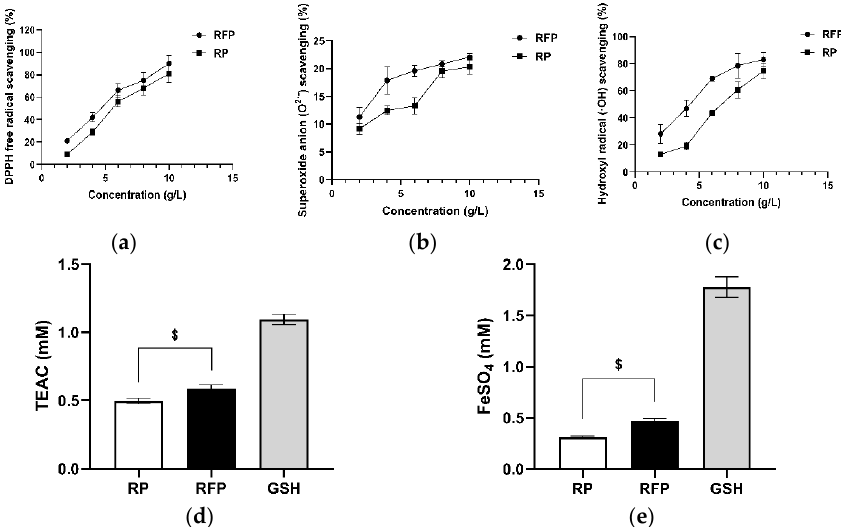
Figure 2. Antioxidant capacity of RFP determined by chemical model method: ( a ) scavenging rate of DPPH·; ( b ) scavenging rate of O 2· − ; ( c ) scavenging rate of ·OH; ( d ) total antioxidant capacity (ABTS assay); and ( e ) total antioxidant capacity (FRAP assay). $ p < 0.033 as compared to RP group. Values do not have a common mark ($) when p > 0.033, the same below.